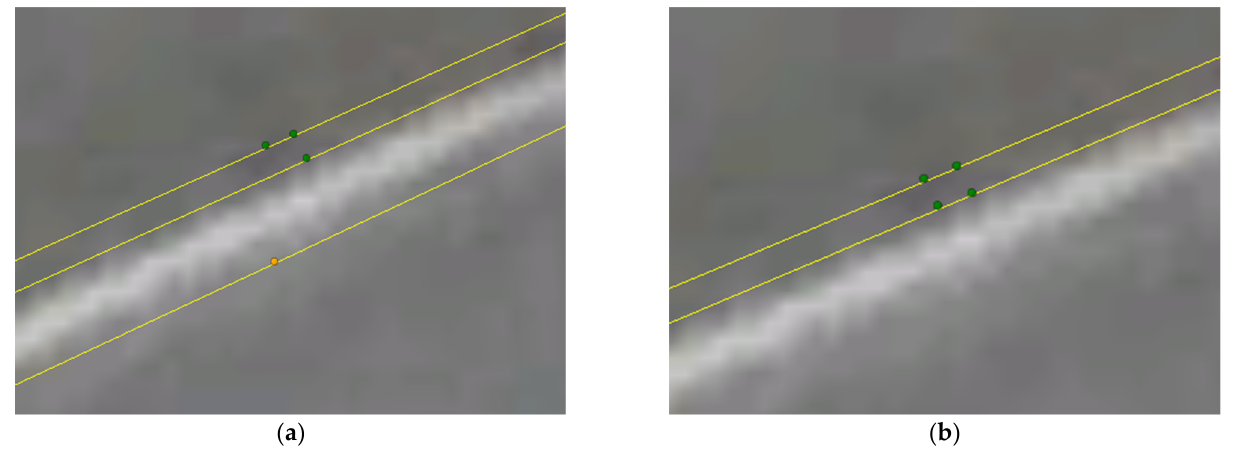
Figure 7. Distribution of four antennas on Google Earth (GPST 03:03:31): ( a ) Result of RTK; ( b ) Result of BCAFM.